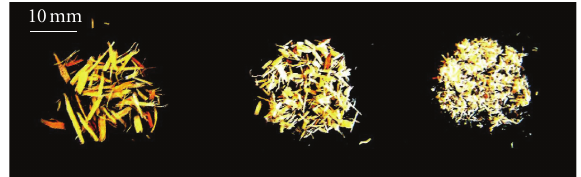
Figure 17: Wood particles processed using di ff erent sieve sizes (sieve size = 4, 2, and 1 mm from left to right).